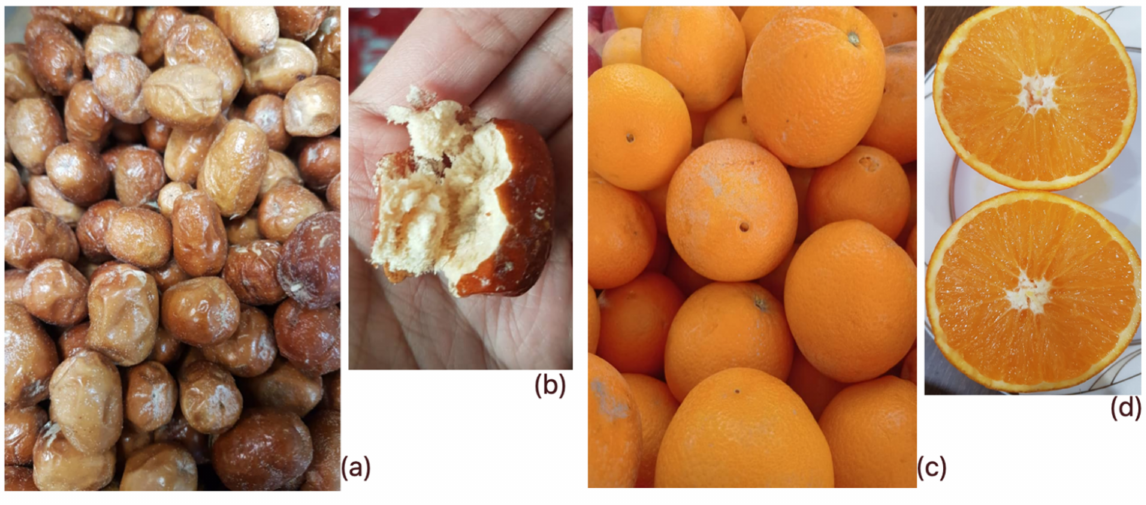
Figure 6. A pictorial representation of the samples of oleaster fruits ( a ) and a view of one when opened ( b ), as well as the samples of orange fruits ( c ) and views of a sectioned slice ( d